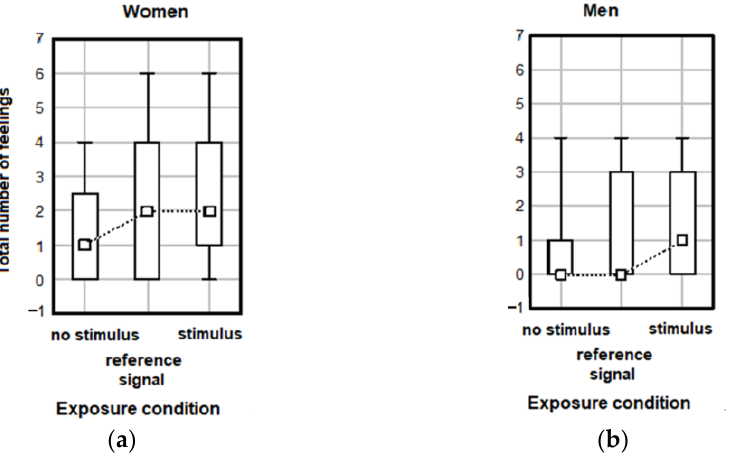
Figure 5. Results of the work under stress simulator test in various exposure conditions among ( a )